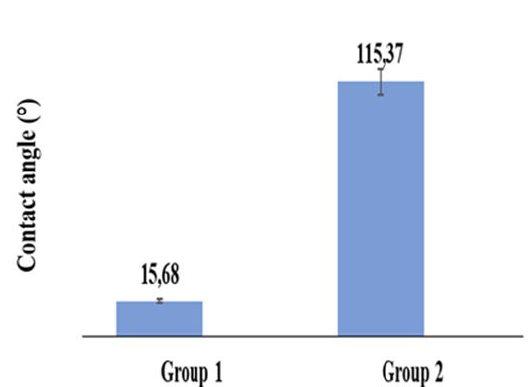
covered with PCL. 2